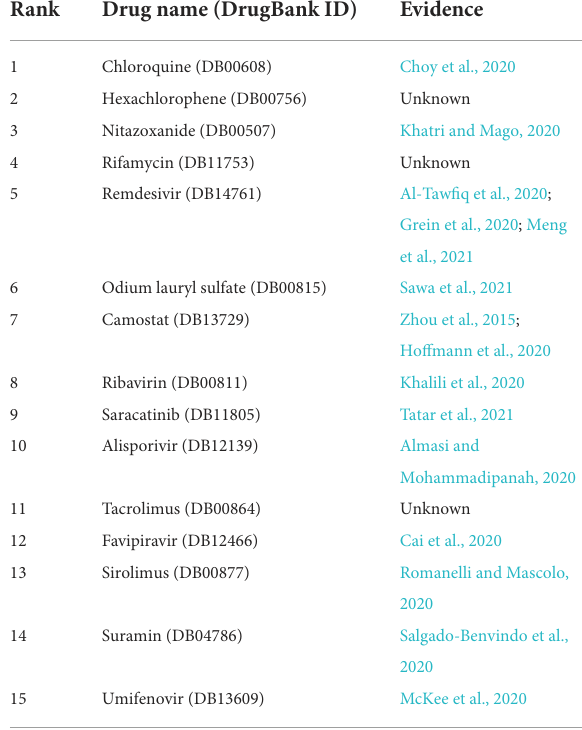
TABLE 3 Top 15 drugs predicted from the HDVD